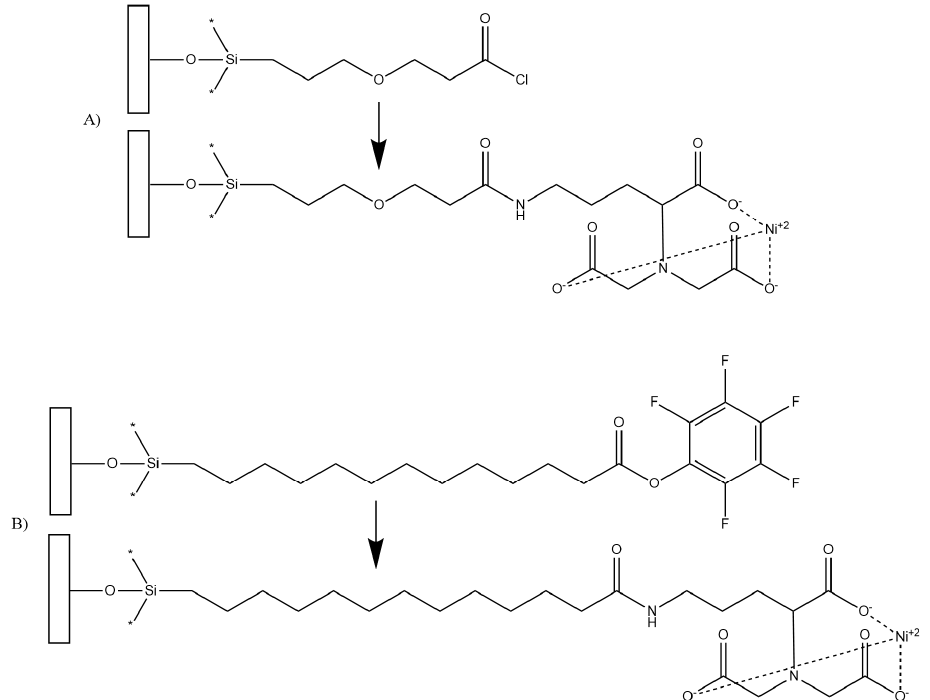
Figure 2. Structures of surface bound 3-(3-(trichlorosilyl)propoxy)propanoyl chloride (MEG-Cl) ( A ) and perfluorophenyl 12-(trichlorosilyl)dodecanoate (PFP-TTTA) ( B ), both before and after extension with Ni-NTA ( N α , N α -bis(carboxymethyl)- L -lysine with nickel).